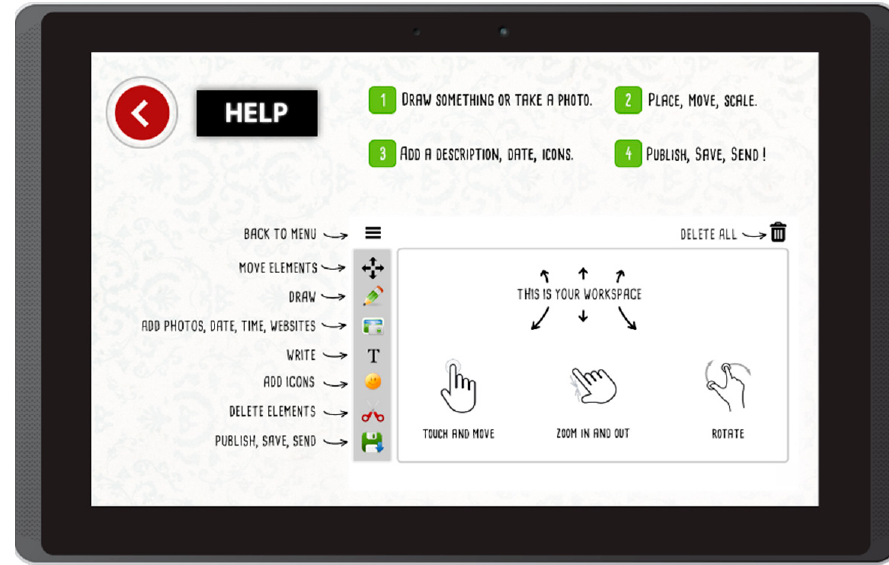
Figure 2. Help screen in Aphasia Create (screenshot from an Android tablet).